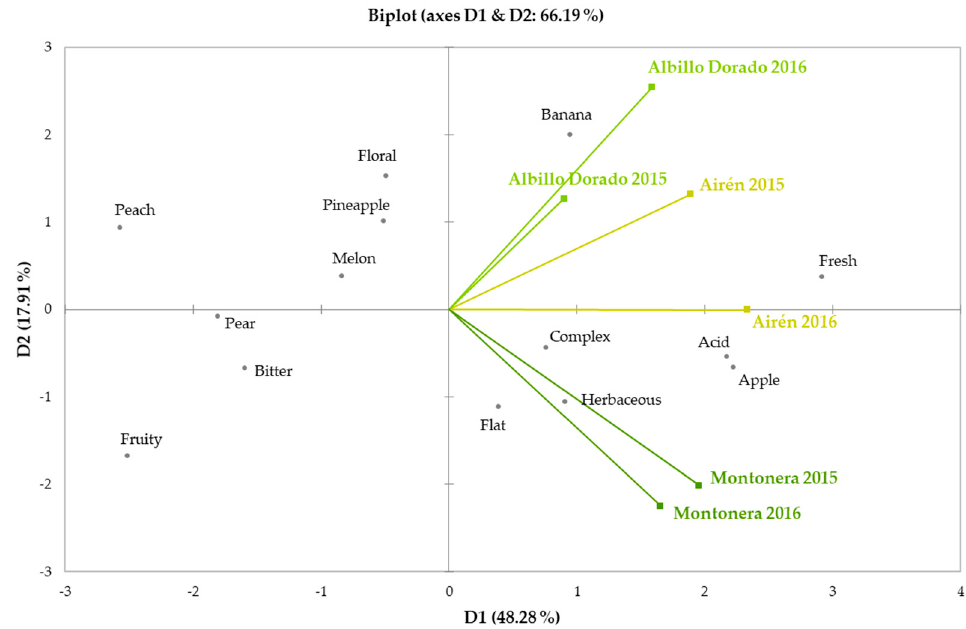
Figure 2. Sensory characterization of the white wines made from Airén and the novel grape genotypes at two consecutive years (2015 and 2016).